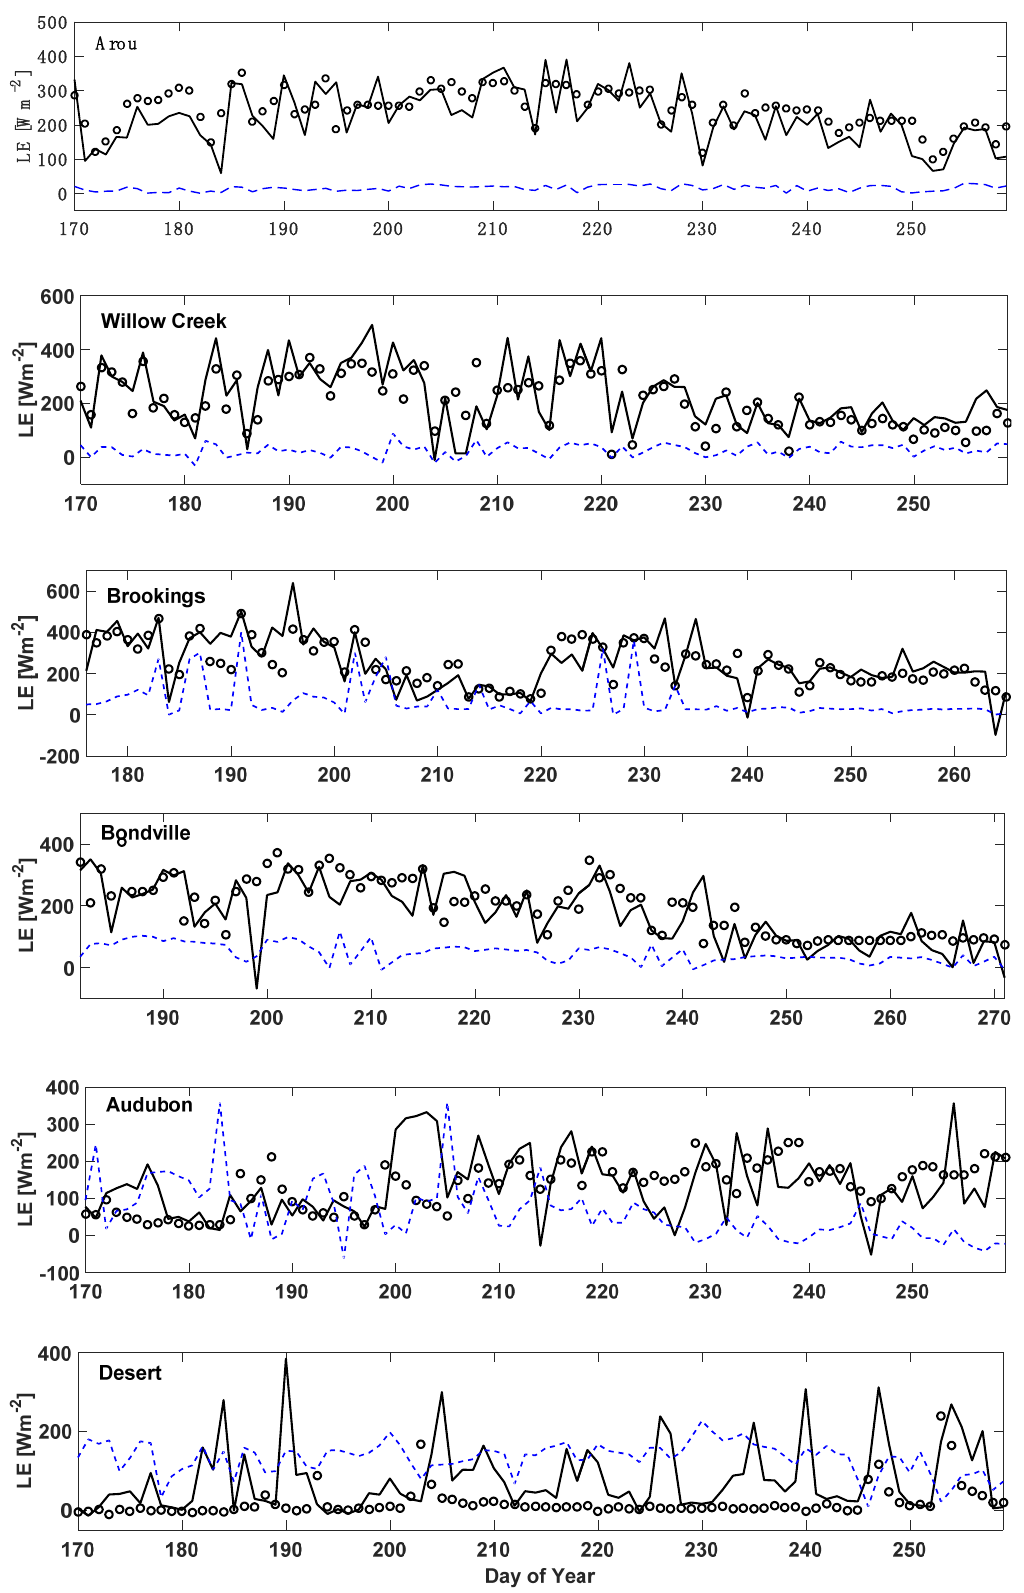
Figure 8. Time series of latent heat flux ( LE ) estimates from the VDA (solid lines) and open loop (blue dashed lines) approaches at the six study sites. Observed LE values are shown by open circles.